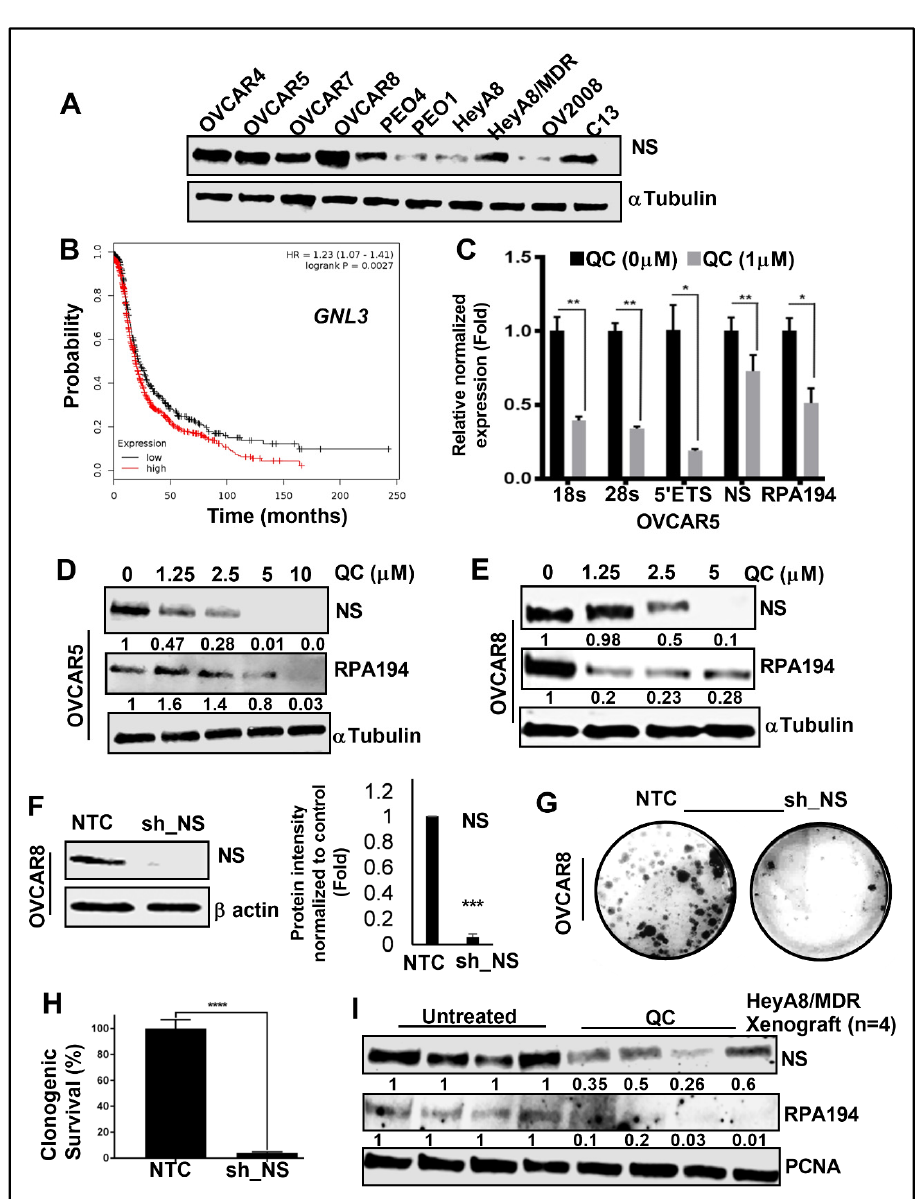
Figure 3. Nucleolar protein NS and RPA194 is downregulated by QC treatment. ( A ) NS protein expression in various OC cell lines was assessed by western blot. α Tubulin was used as loading control. ( B ) Kaplan–Meier progression-free survival (PFS) analysis shows high GNL3/NS expression is associated with worse PFS in OC patient’s cohort. ( C ) Relative expression changes for ribosomal subunits NS and RPA194 after 1 h of 1 µM QC treatment in OVCAR5 OC cells (normalized to RPLP0; n = 3) * ( p < 0.05), ** ( p < 0.01). ( D ) Immunoblot analysis of NS and RPA194 expression in OVCAR5 and ( E ) OVCAR8 cells upon QC treatment for 24 h in a dose dependent manner. α Tubulin was used as loading control. Densitometric analysis was performed using Image J, normalized to endogenous control and the fold change was provided beneath the panel. ( F ) shRNA-mediated stable NS knockdown OVCAR8 cells were generated, and the knockdown effect was validated by western blot analysis. α Tubulin was used as loading control. Densitometric analysis was performed using Image J, normalized and fold change was plotted *** ( p < 0.001). ( G , H ) Clonogenic OVCAR8 cell viability after NS knockdown compared to NTC transfection ( n = 3). Error bars represent standard error, and significance is denoted by **** ( p < 0.0001). ( I ) Western blot analysis was performed in untreated control and QC-treated HeyA8-MDR OC xenograft tumors against NS and RPA194 expressions. PCNA was used as loading control. Fold change was analyzed and provided beneath the panel. Abbreviations: QC: Quinacrine; NS/GLN3: Nucleostemin, RPA194: RNA Polymerase I Subunit A; NTC: non-targeted control, sh_NS: shRNA-mediated NS downregulation; PCNA: Proliferating cell nuclear antigen.